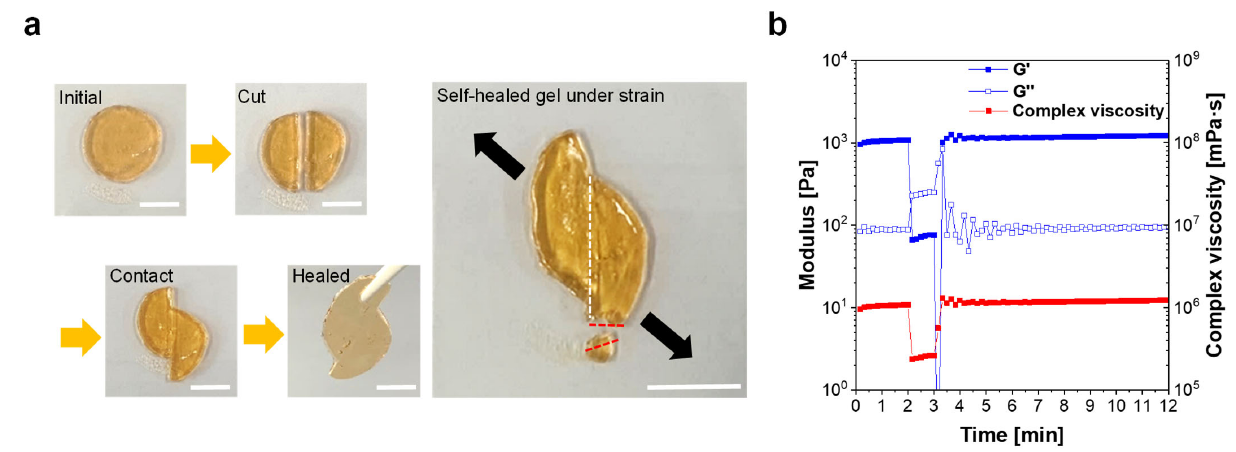
Figure 2. Characterization of the self-healing properties of the new PAA-based self-healing hydrogel. ( a ) Cut-and-contact self-healing test (scale bar: 10 mm). ( b ) Time-dependent recovery test of the hydrogel under varied shear strain conditions; 5% for initial 2 min, followed by 400% for 1 min, and 5% for 10 min (at 1 rad/s).